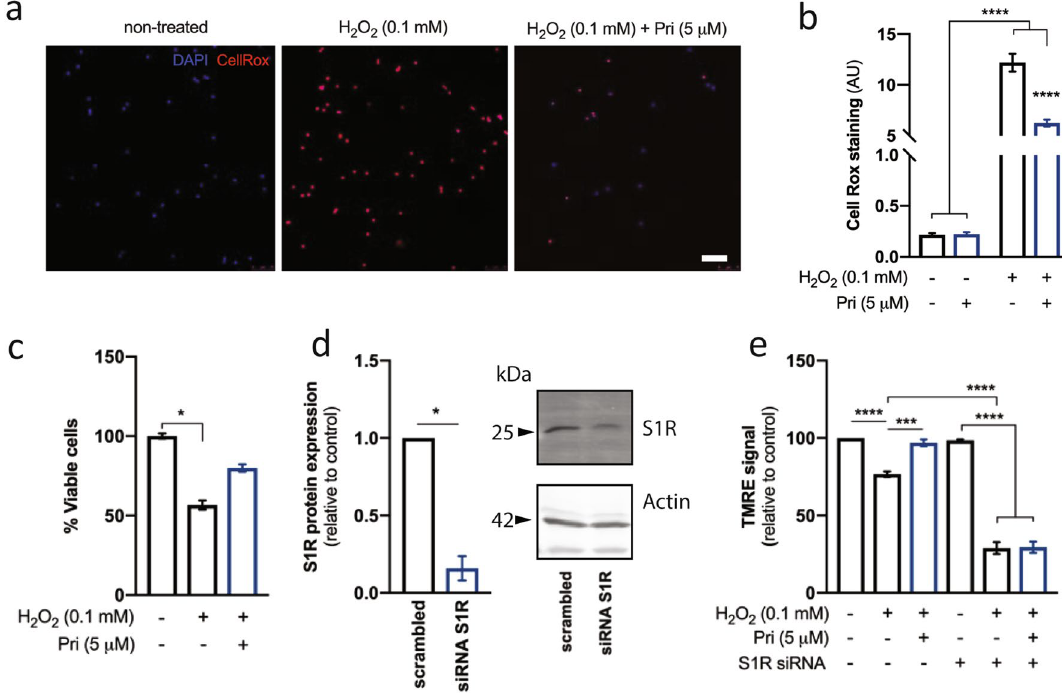
Figure 6. Pridopidine prevents H 2 O 2 -induced mitochondrial dysfunction and cell death in lymphoblasts through S1R. Human lymphoblasts were incubated with pridopidine (5 µM, 24 h) followed by H 2 O 2 (0.1 mM, 6 h). ROS levels were quantified by co-staining with CellRox and DAPI. ( a ) Representative image and ( b ) quantification. Two-way ANOVA indicate an effect of H 2 O 2 [F(1,12) = 373.8; p < 0.0001] and pridopidine [F(1,12) = 40.61; p < 0.0001] treatment. ( c ) Cell viability was determined by MTS assay. Lymphoblasts were subjected to S1R knockdown, confirmed by western blotting ( d ), and mitochondrial membrane potential was evaluated using TMRE ( e ). Data is the mean ± SEM. *p < 0.05, ***p < 0.001, ****p < 0.0001 by two-way ANOVA with a Tukey’s multiple comparisons in ( b ), by non-parametric Mann–Whitney in ( d ), or Kruskal–Wallis test in ( c ) and ( e ). Full-length blots are presented in Supplementary Fig.